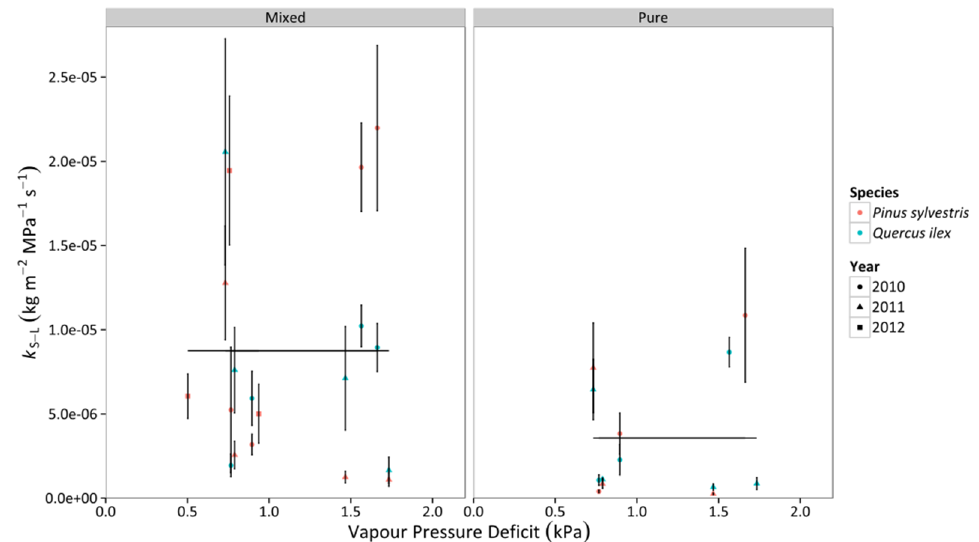
Figure 7. Responses of whole-tree leaf-specific conductance ( k S–L ) to daytime averages of VPD in two different stand types throughout three consecutive years. Average values for P. sylvestris and Q. ilex trees are shown. Error bars indicate ±1 SE. The regressions for the different combinations of species and stand type according to best-fitting models are also depicted ( cf. Table